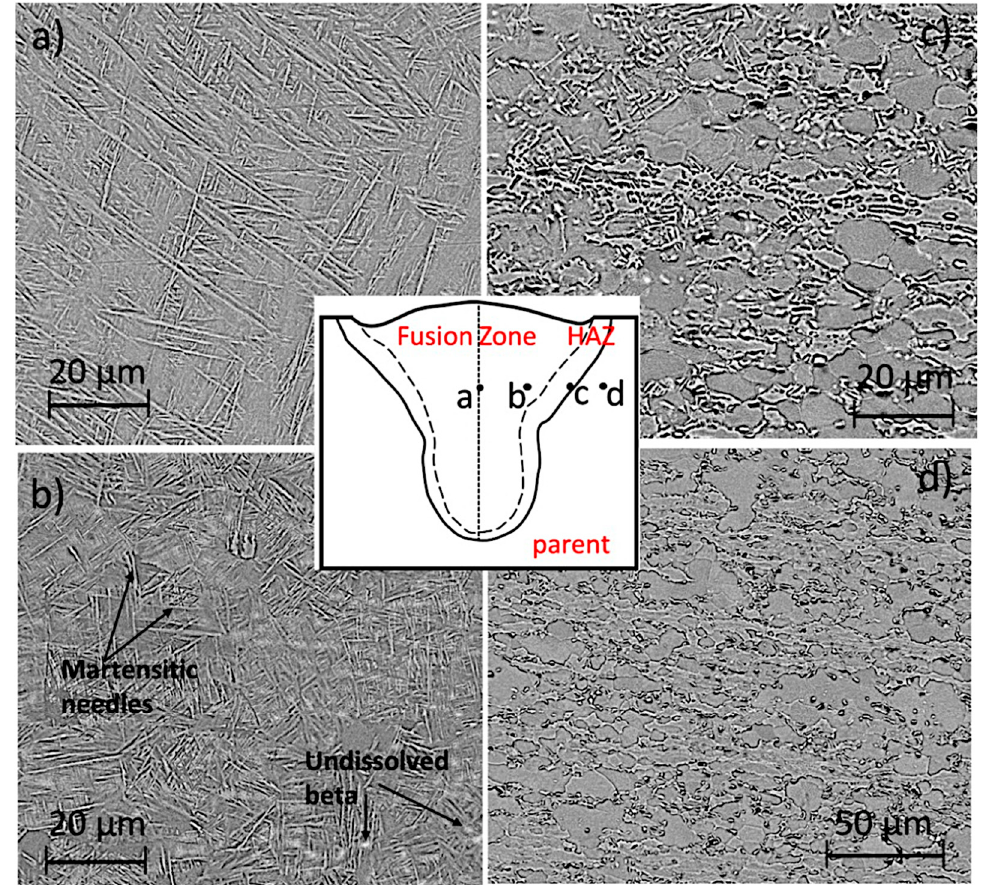
Figure 6 . Backscattered SEM images of weld c, involving a 5.8-mm-thick equiaxed plate welded at 2 m min − 1 and 4 kW for locations ( a – d ) shown.